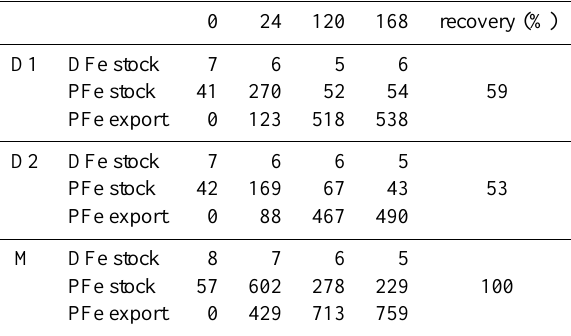
Table 8. Iron budget estimated from measured data and model (mg) under dust addition. D1–D2 stand for the two mesocosms with dust addition shown in Wagener et al. (2010) and M for model results. Time (0–168) is in hours after dust addition. DFe and PFe stock are the total mass in the water column. PFe export is the cumulative export from dust addition to the corresponding time points. “recov- ery” is calculated as the sum of iron stock and export divided by the iron input by dust addition.